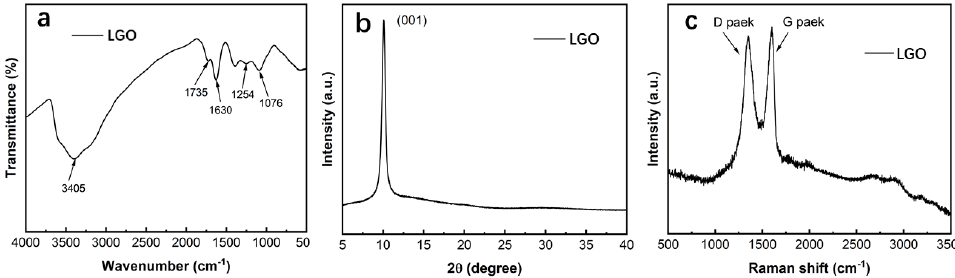
Figure 3. Chemical composition and structural characterization of LGO: ( a ) FTIR spectrum; ( b ) XRD; ( c ) Raman spectrum.